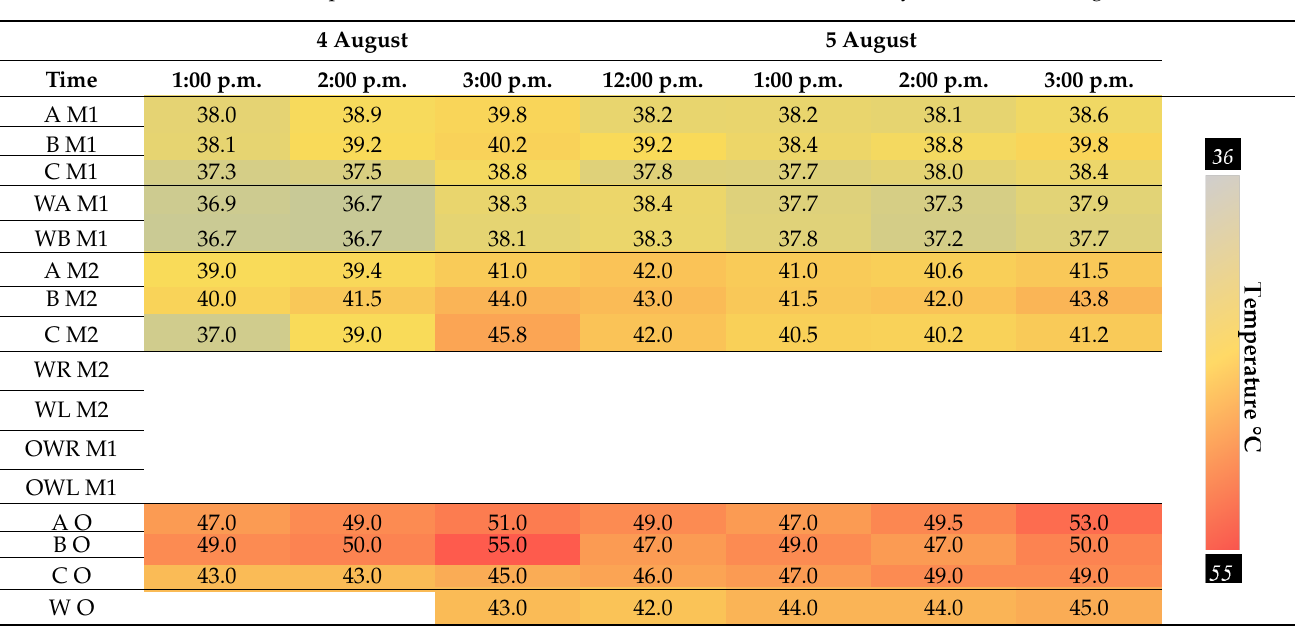
Table 11. Surface temperatures of Room 1, Room 2, and the courtyard on 11, 13 and 18 August 2018.